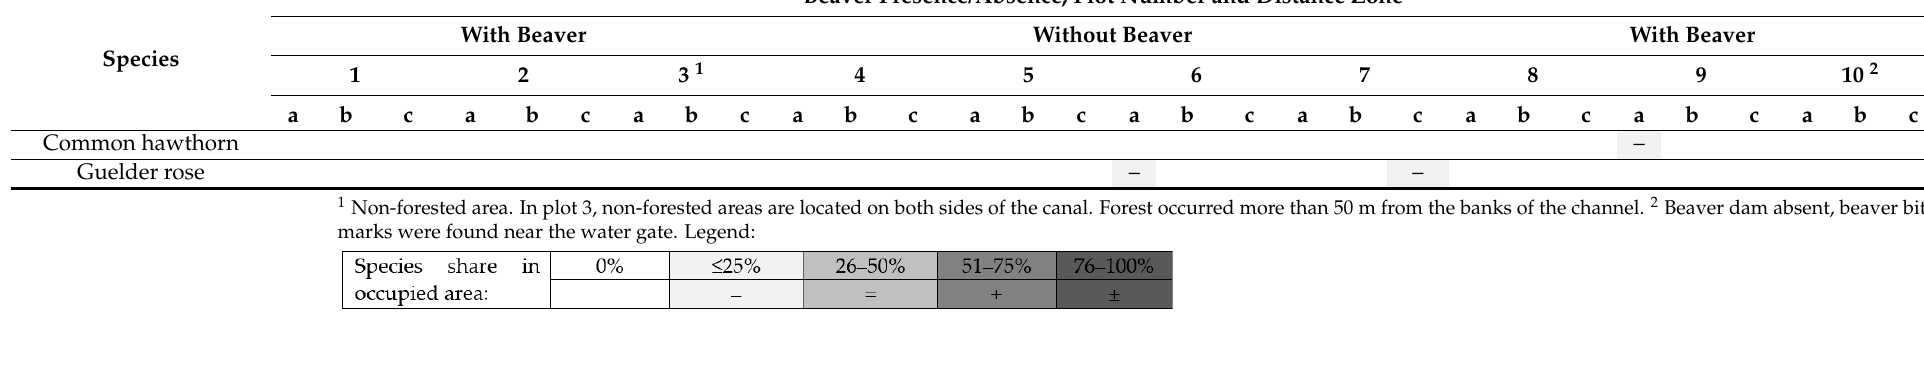
With Beaver Without Beaver With Beaver